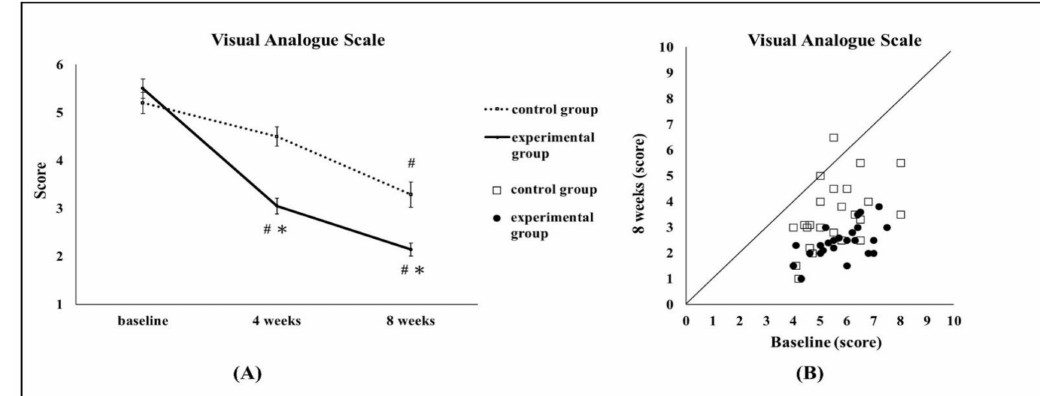
Figure 2. Visual analogue scale (VAS) scores at baseline, four weeks, and eight weeks between the control group (CG) and experimental group (EG) ( n = 24 per group). ( A ) The dashed line indicates the trend of VAS scores of the CG and the solid line indicates that of the EG (mean ± SE). #: significant difference compared to the baseline within the group ( p < 0.05). *: significant difference between EG versus CG ( p < 0.05). ( B ) The identity plot presents the distribution of the individual VAS scores of the control group (CG: empty square) and the experimental group (EG: solid circle) at eight weeks of treatment. The identity line indicates no change of the VAS scores after eight weeks of treatment; the upper half of the identity line means more pain than the baseline; the lower half of the identity line means less pain than the